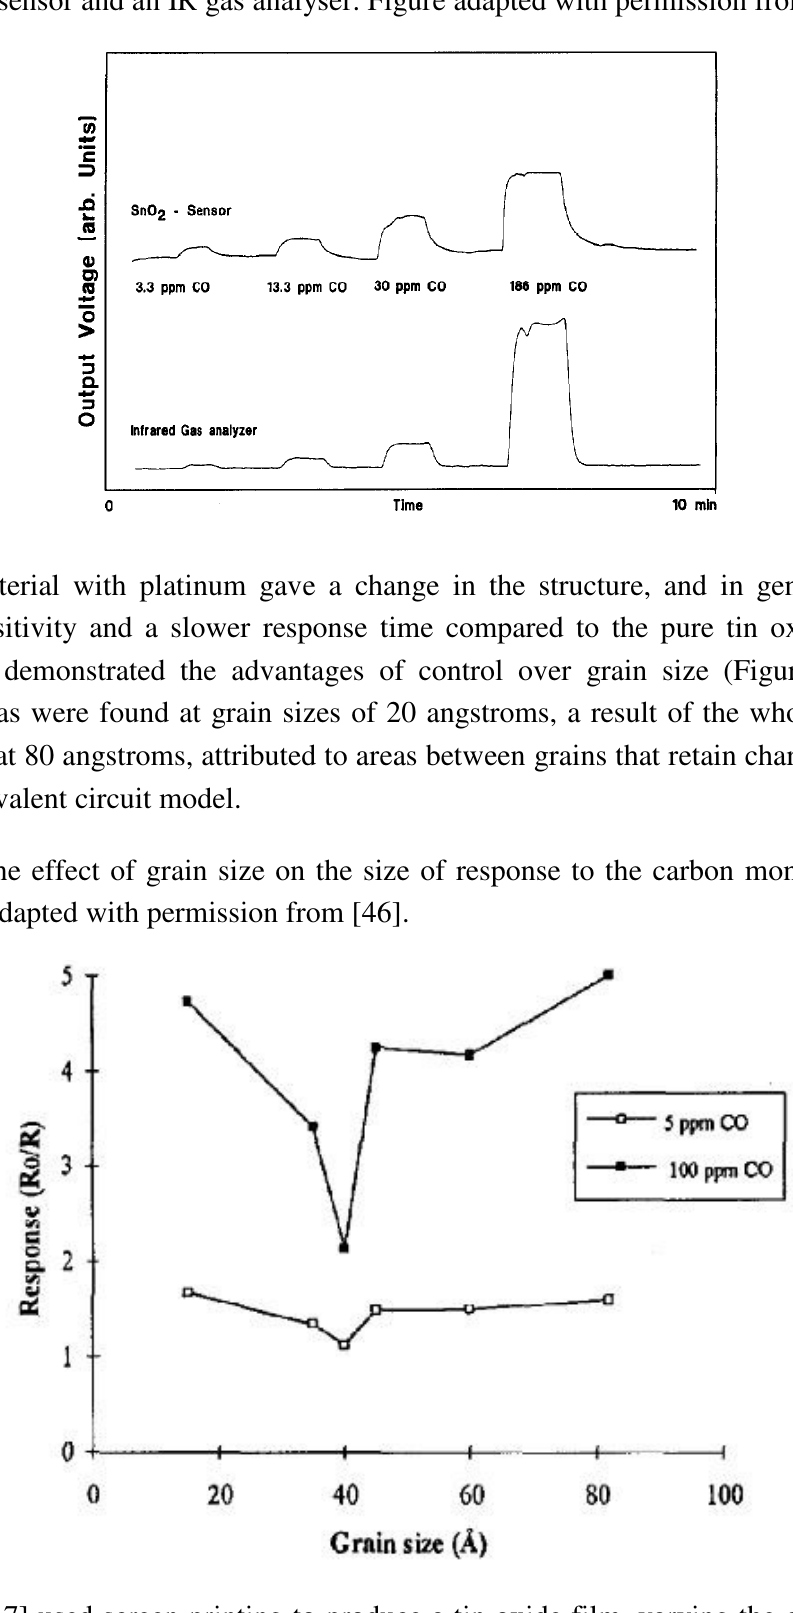
Figure 7. Showing the sensor response to varying concentrations of carbon monoxide for both a SnO sensor and an IR gas analyser. Figure adapted with permission from [45]. 2